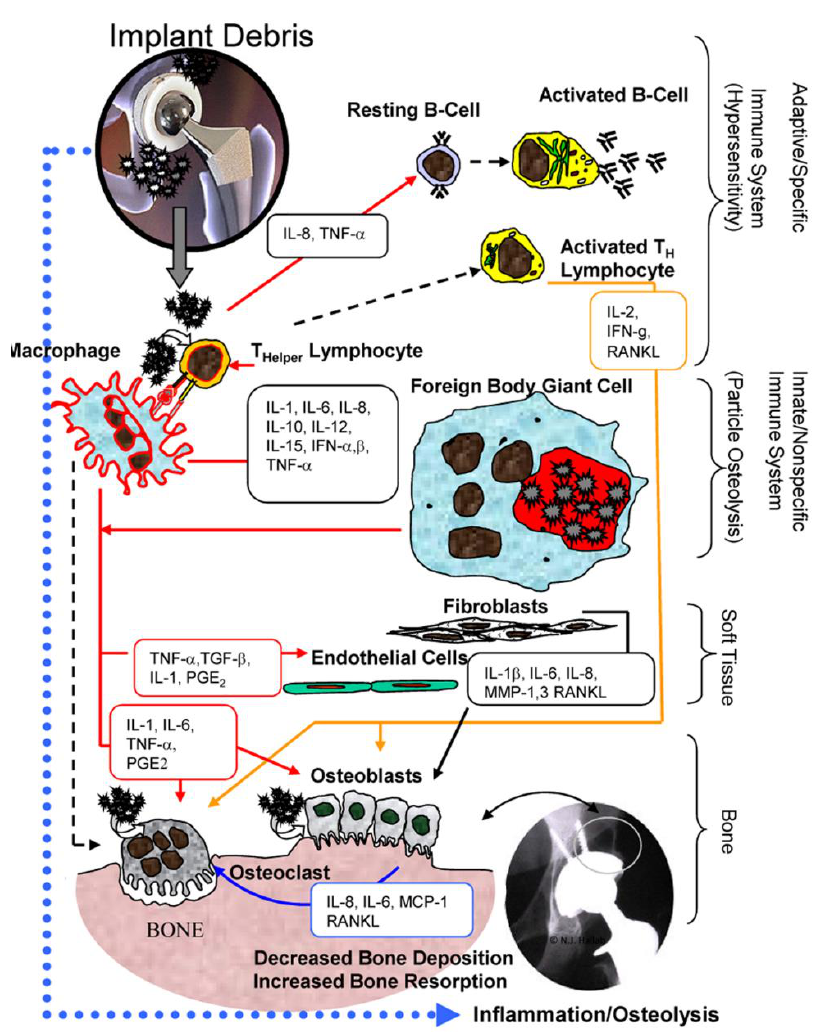
Figure 3. The biologic reactivity of implant debris causes local immune responses primarily mediated by macrophages, which produce reactive oxygen intermediates and pro-inflammatory cytokines that affect a host of local cell types and induce a widening zone of soft-tissue damage and inflammation [69]. Reprinted with permission from Springer Nature.